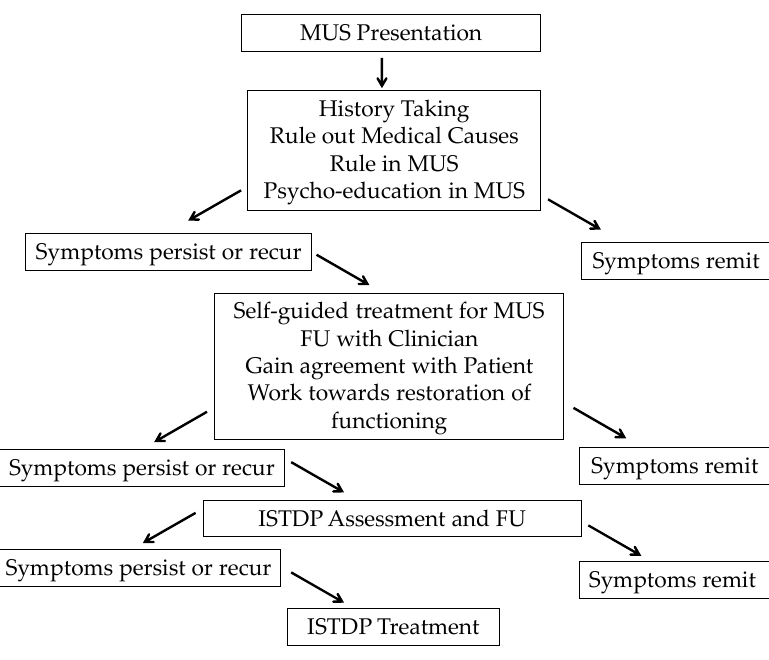
Figure 1. Proposed MUS pathway for development.